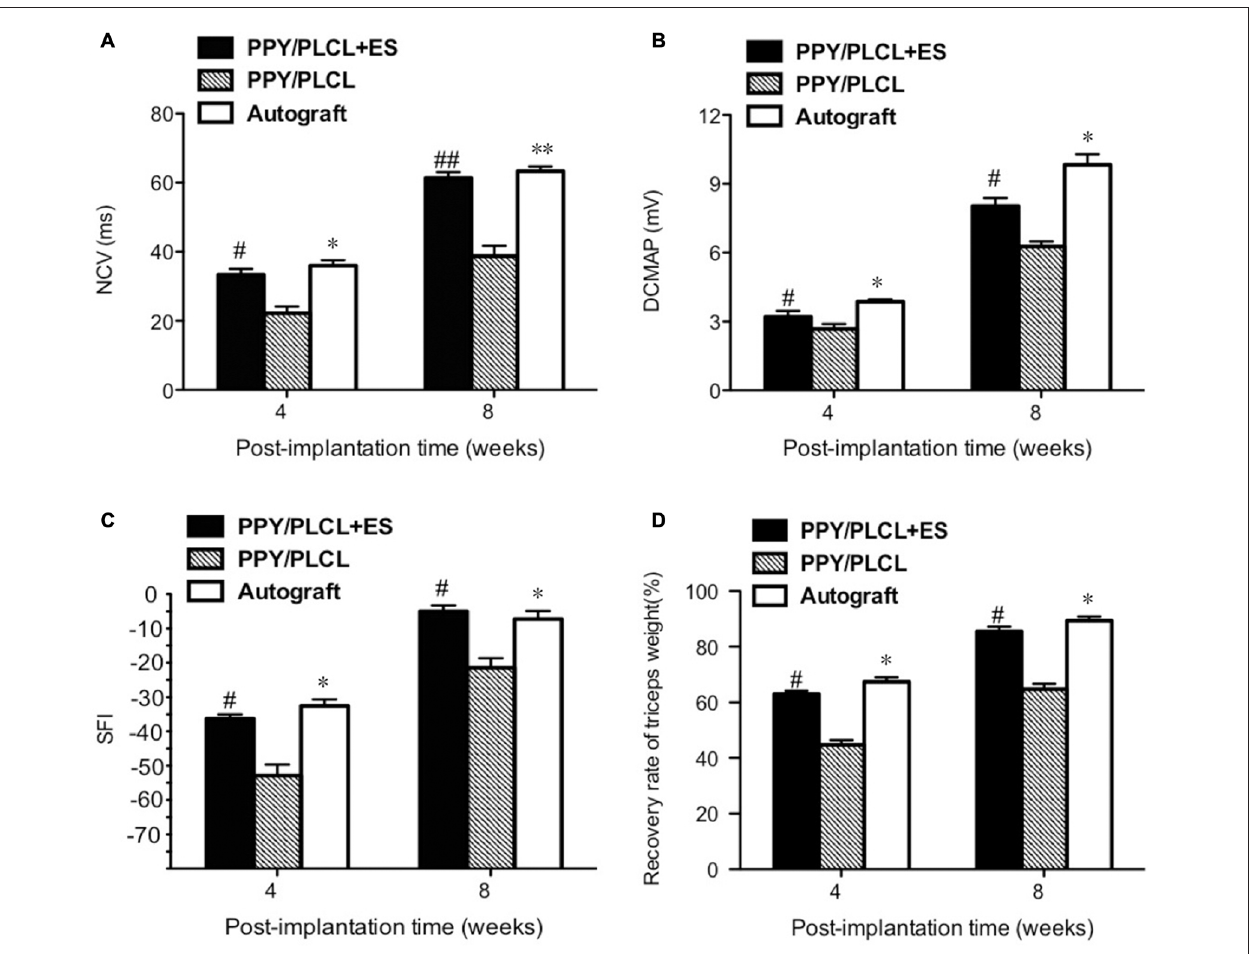
FIGURE 6 | Electrophysiological and functional evaluation 4 and 8 weeks post-implantation. (A) Nerve conduction velocity (NCV). (B) Distal compound motor action potential (DCMAP). (C) Sciatic function index (SFI). (D) Recovery rate of triceps weight ( n = 5, # p < 0.05, ## p < 0.01 the PPY/PLCL + ES group vs. PPY/PLCL group; ∗ p < 0.05, ∗∗ p < 0.01 the autograft group vs. PPY/PLCL